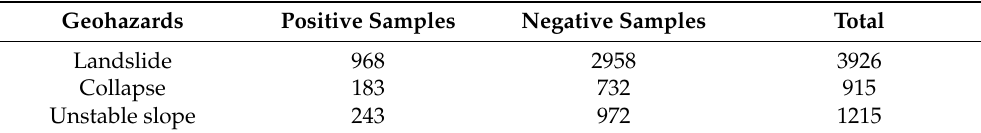
Table 4. Sample number within each sampling